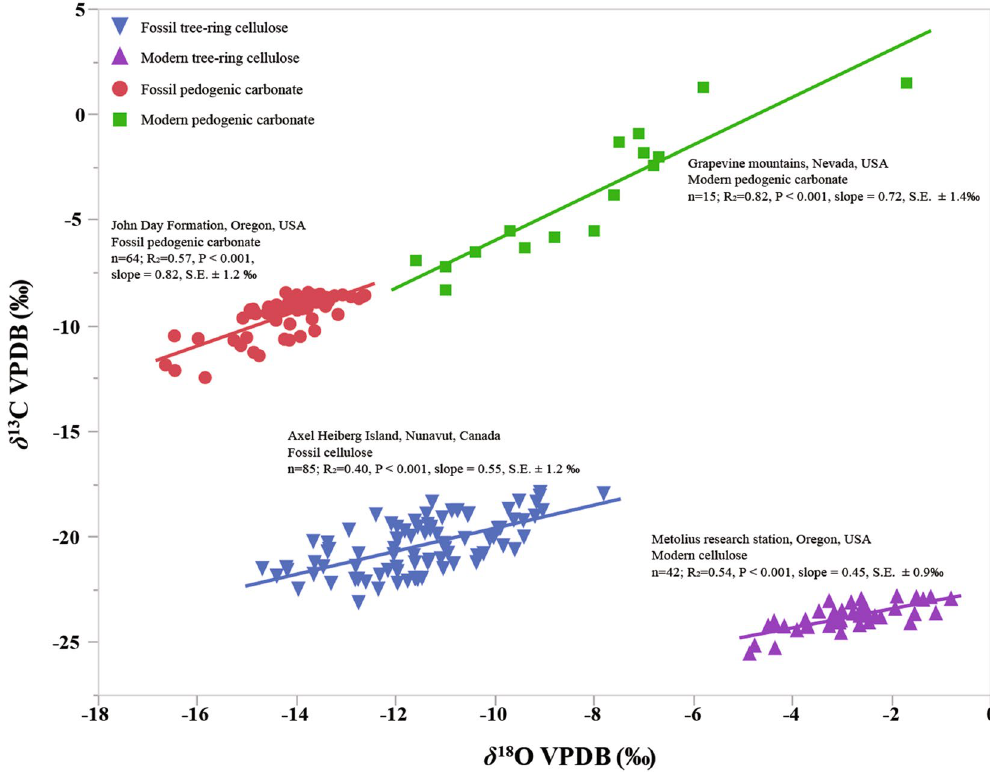
Figure 5. Relationship between δ 13 C and δ 18 O in select modern and fossil samples (from Fig. 3) used for estimating paleo-VPD. Fossil samples (circles and triangles) of cellulose and carbonate are from the Eocene (45 Ma) and Oligocene (26 Ma), respectively. All cellulose δ 18 O values were recalibrated to the VPDB scale (Table S7). Both modern and fossil isotopic datasets are listed in Table S3 (for cellulose) and Table S4 (for